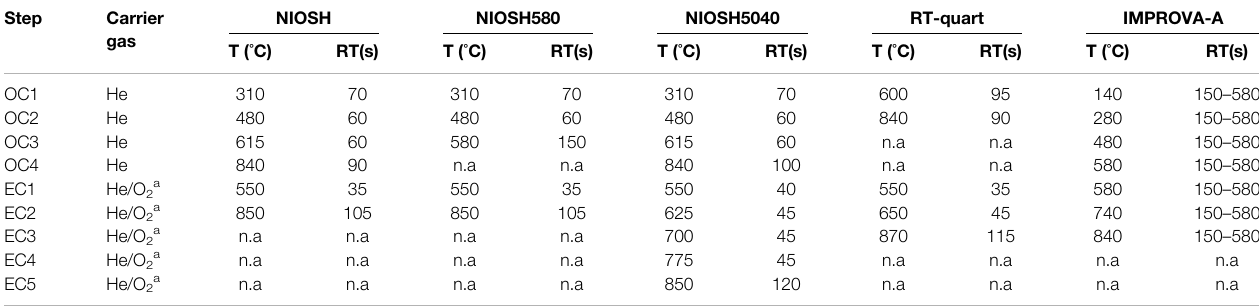
TABLE 1 | Temperature programs (T) and residence time (RT) of the fi ve protocols (NIOSH, NIOSH580, NIOSH5040, Rt-quartz, and IMPROVE-A). Step Carrier gas